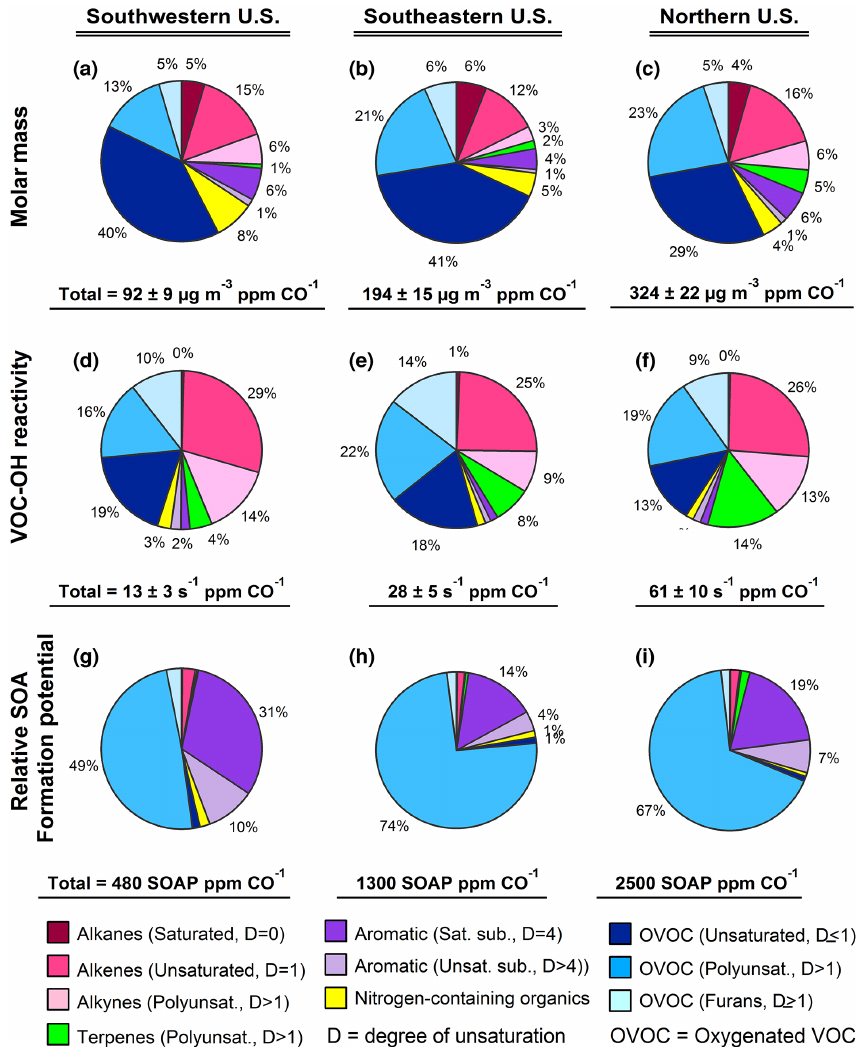
Figure 5. Contributions of (non-methane) VOCs reported in Table 2 to (a) – (c) the measured molar mass, (d) – (f) OH reactivity, and (g) – (i) relative SOA formation potential for the southwestern, southeastern, and northern fuel regions. Totals for each fuel region are shown below each pie